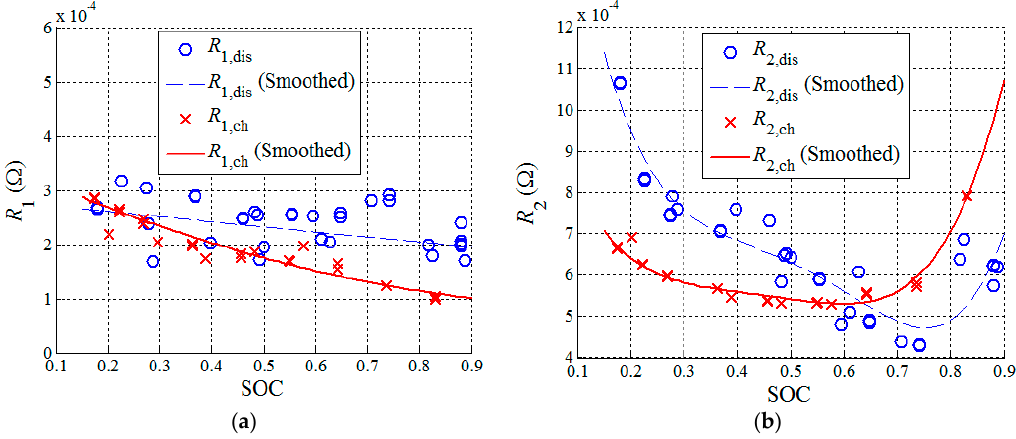
Figure 3. Identified parameters versus SOC at baseline currents including ( a ) R 1 and ( b ) R 2 .